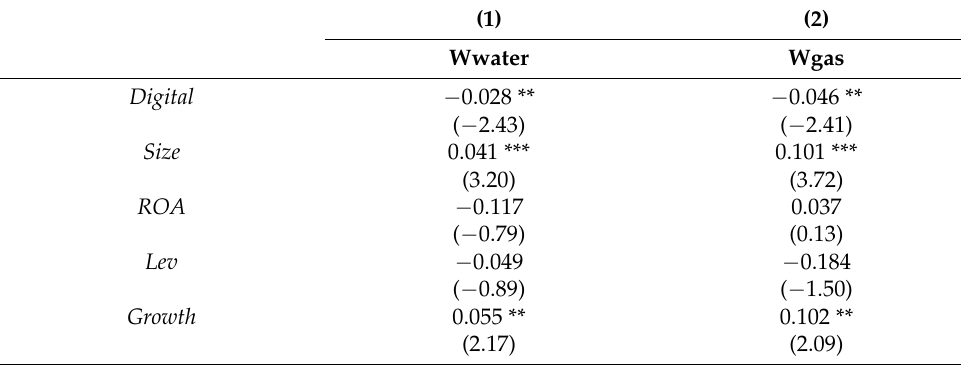
Table 2. Baseline regression. This table reports the results of OLS regressions examining the effect of digital transformation on environmental pollution. Appendix A provides definitions of the variables. The regressions control for a year and Industry fixed effects. In parentheses are t -statistics based on standard errors adjusted for heteroskedasticity and firm